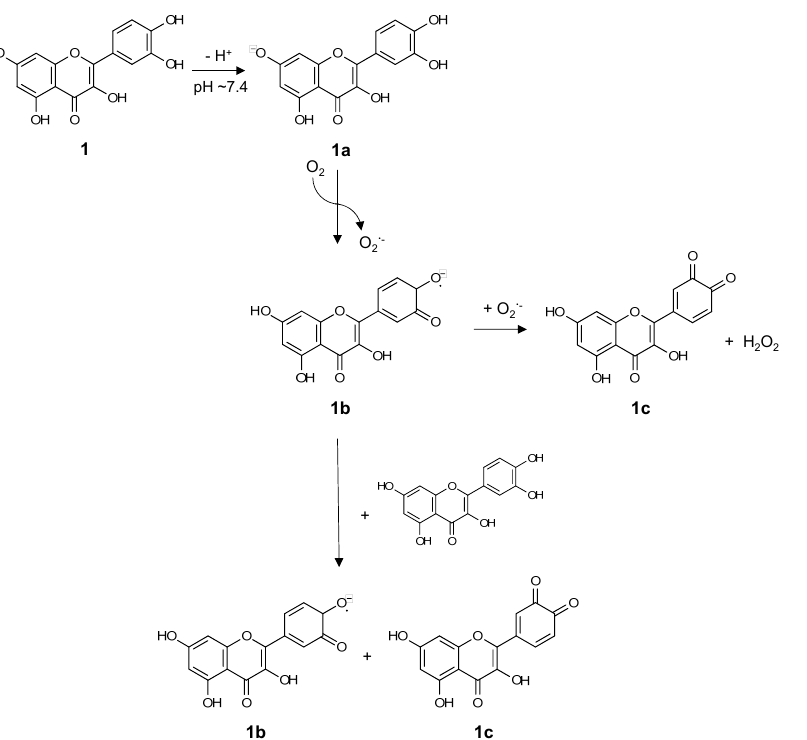
Figure 4. Glutathione forms flavonoid adducts via Michael addition to the quinone methide isomers of oxidized quercetin.